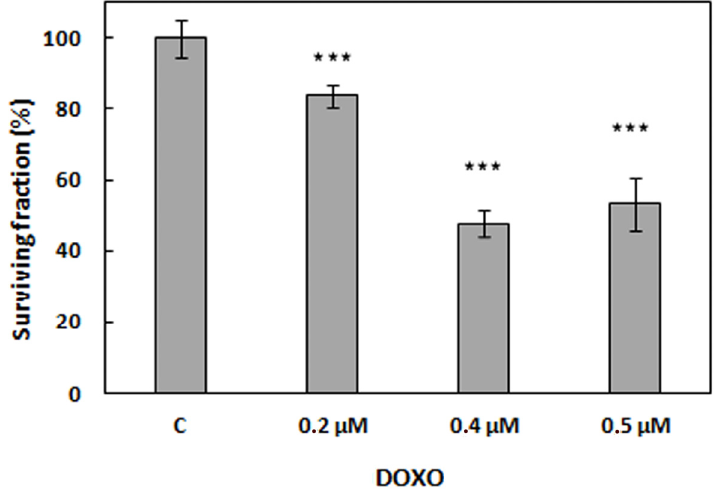
Figure 10. Viability of HeLa cells treated with DOXO for 24 h at different concentrations and non-treated control cells (c). *** p < 0.001. The standard deviation (SD) is the average of at least three experiments.